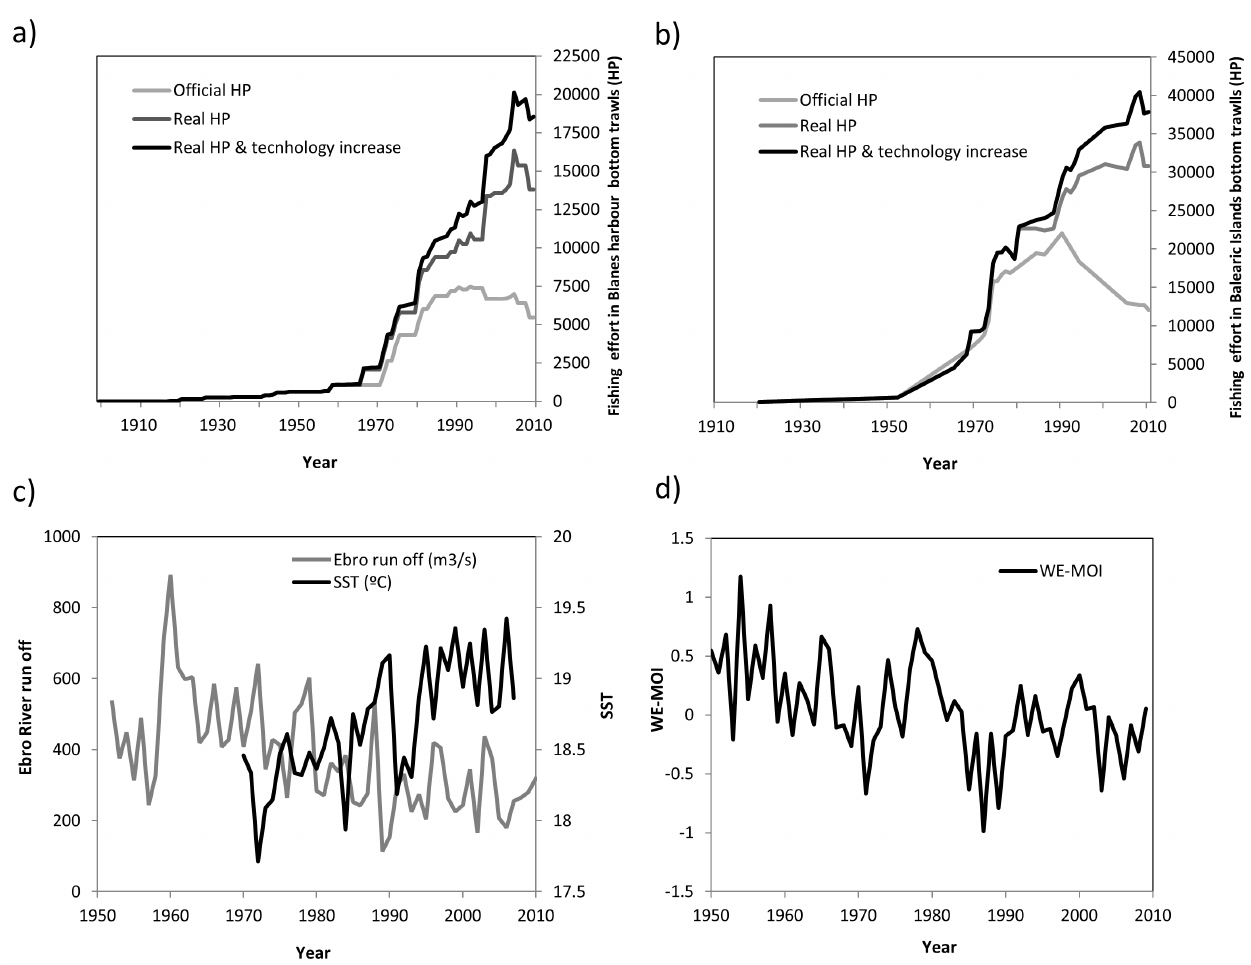
Figure 11. Temporal evolution of a) Bottom trawling fishing effort in the Blanes harbour (NW Mediterranean Sea) from 1900 to 2013 (HP; data sources: Annex S1), b) Bottom trawling fishing effort in the Balearic Islands (NW Mediterranean Sea) from 1920 to 2010 (HP; data sources: Annex S2), c) Ebro River water runoff from 1953 to 2010 (m3/s, annual mean; data sources: Ebro Hydrographical Confederation, Tortosa station, http://www.chebro.es/) and Sea Surface Temperature (SST) from 1970 to 2007 ( 6 C, annual mean; data sources: data was collected near Tarragona, 40 6 N–2 6 E, Smith and Reynolds, 2004); and d) Western Mediterranean Oscillation Index from 1950 to 2009 (WEMOI; Error! Hyperlink reference not valid., [ 76 ] ).